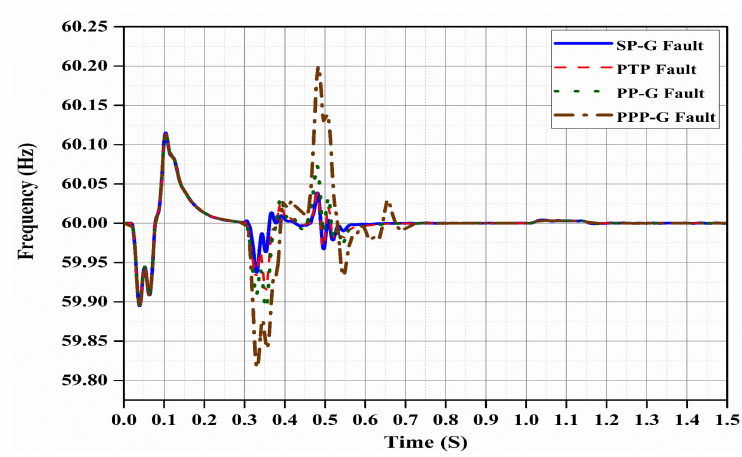
Figure 6. The variations of frequency at the PCC during grid fault conditions.